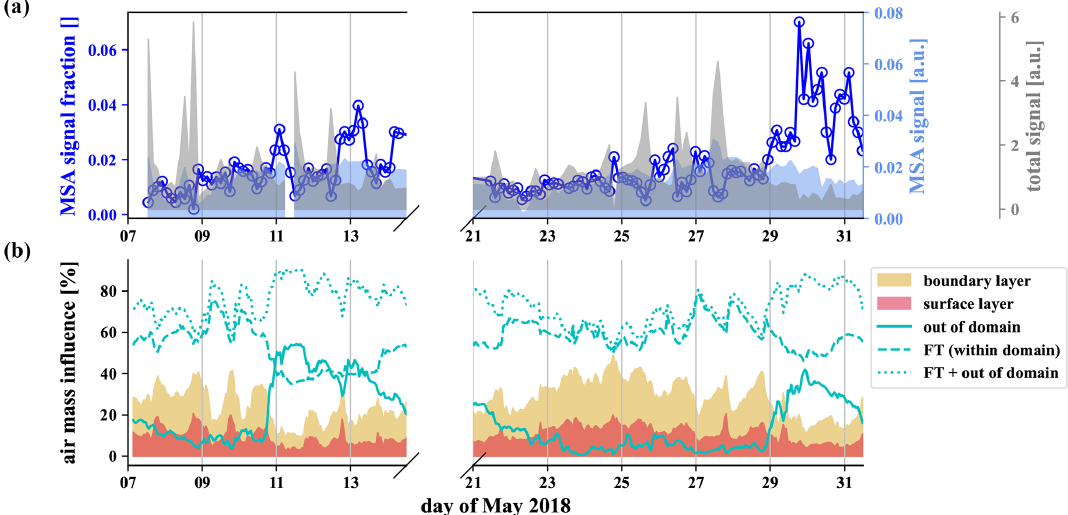
Figure 7. MSA from the particle phase, evaporated and detected by the I − -FIGAERO-CIMS (a) and FLEXPART analysis of the relative influence of the different air masses (b) . A strong increase of the methanesulfonate fraction within the particles is observed when the influence of free tropospheric long-range transport increases.